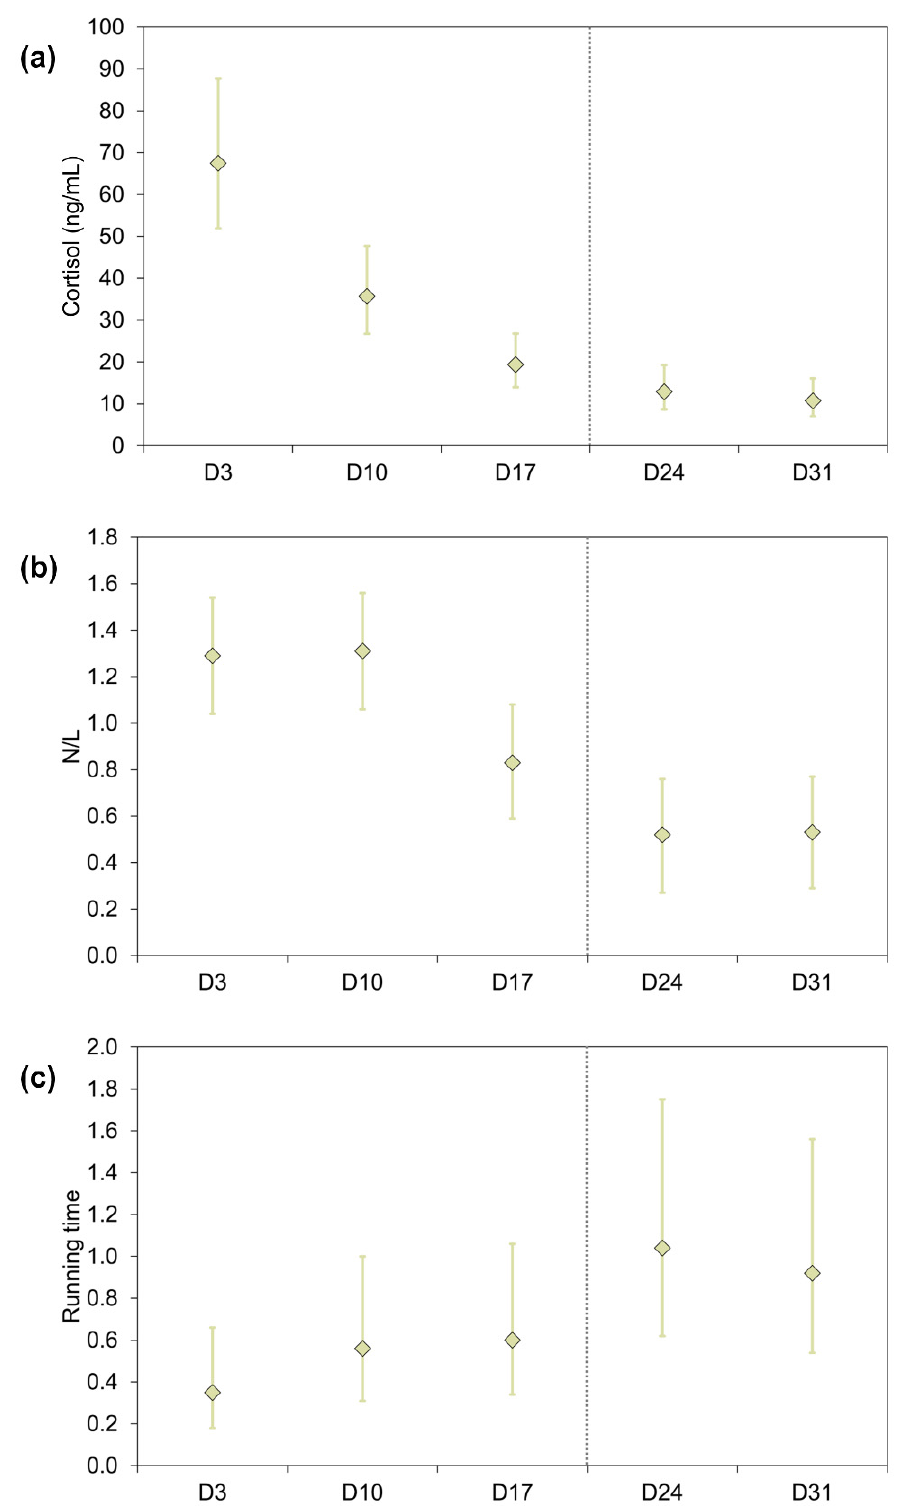
Figure 2. Estimated model means and 95% confidence intervals based on Generalized Linear Mixed Models to understand the differences in cortisol ( a ), neutrophil-to-lymphocyte ratio (N/L) ( b ) and relative time spent running ( c ). Data are based on 21 dairy calves observed every week from the 3rd to 31st day of age (D3, D10, D17, D24, D31) at CiRAA (Centro di Ricerche Agro-Ambientali “E. Avanzi”—University of Pisa). Dotted lines indicate the approximate time of disbudding.